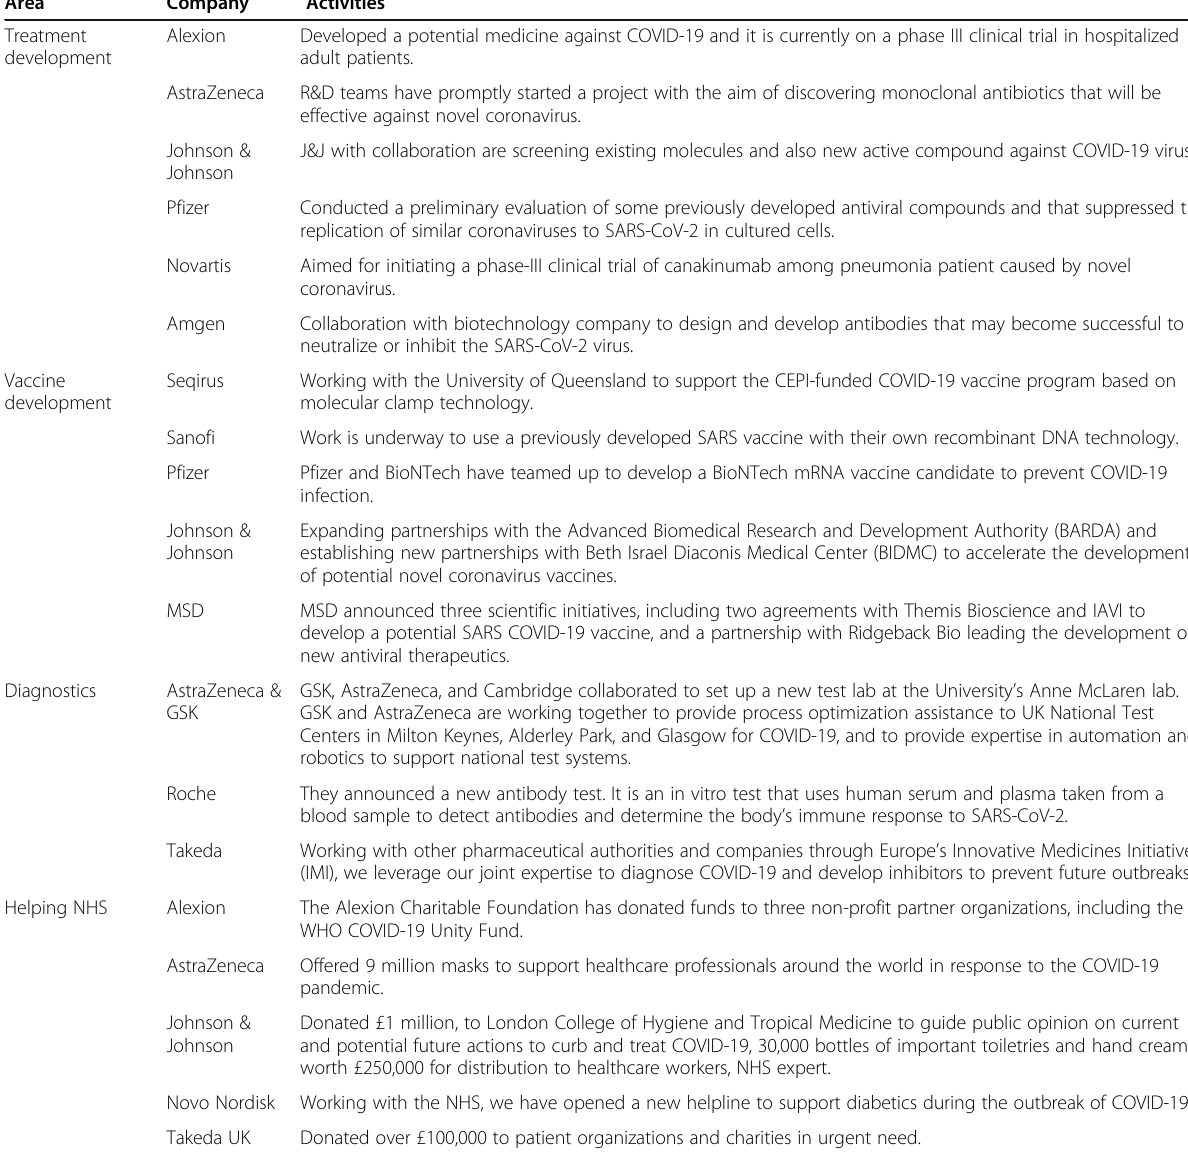
Table 3 The contributions of pharmaceutical companies during COVID-19 pandemic